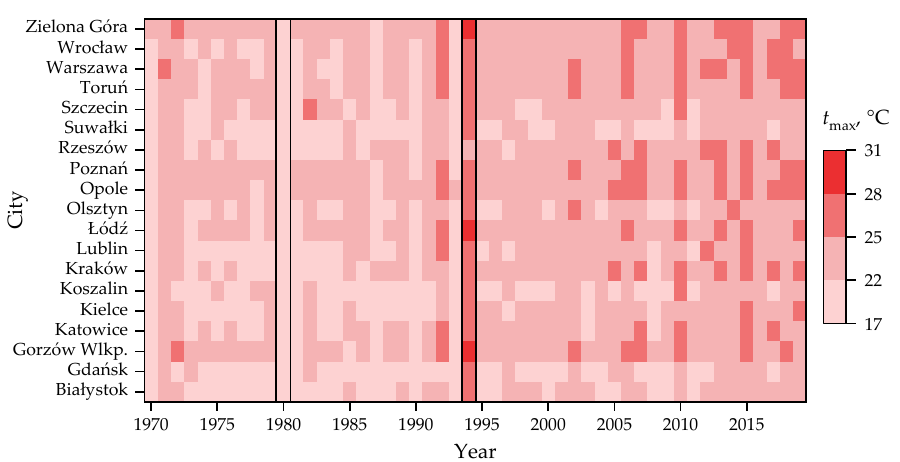
Figure 6. Maximum five-day temperatures ( t max , °C) recorded between 1970 and 2019.